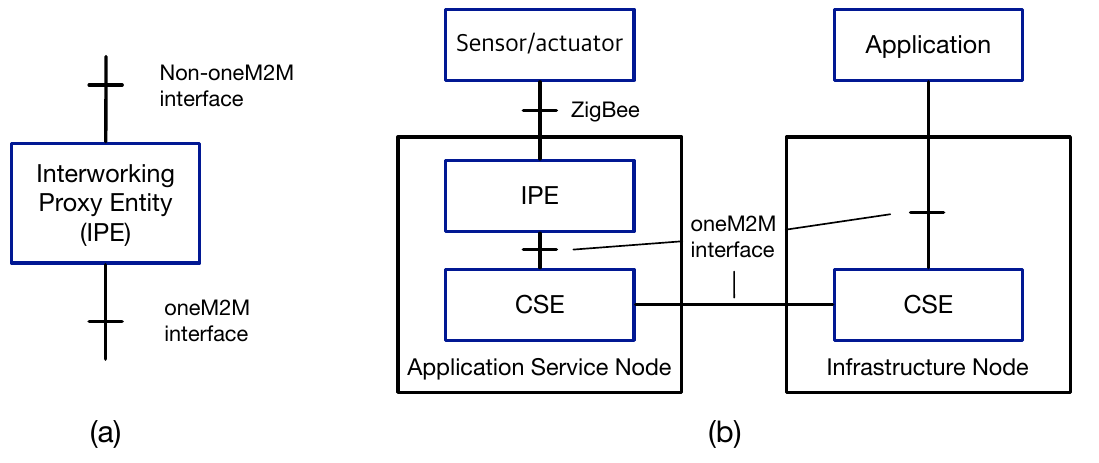
Figure 4. ( a ) Interworking proxy entity (IPE) for interworking with non-oneM2M systems and ( b ) an interworking example for ZigBee-based